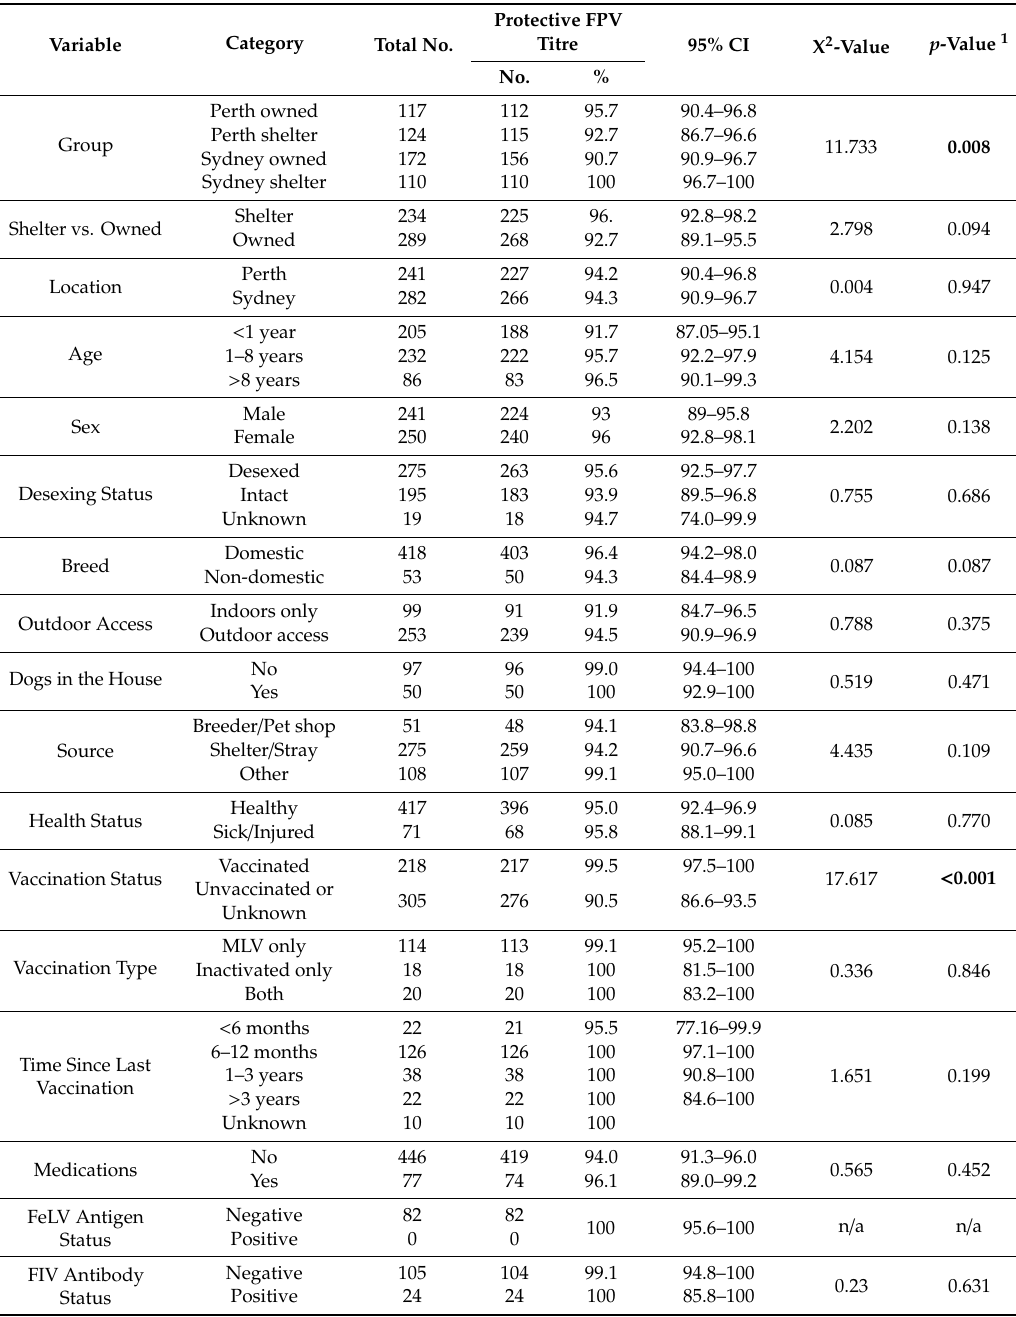
Table 1. Descriptive and univariable analysis of risk factors potentially associated with a protective feline parvovirus serum haemagglutination antibody titre ( ≥ 1:40) for 523 shelter-housed and owned cats tested from Sydney and